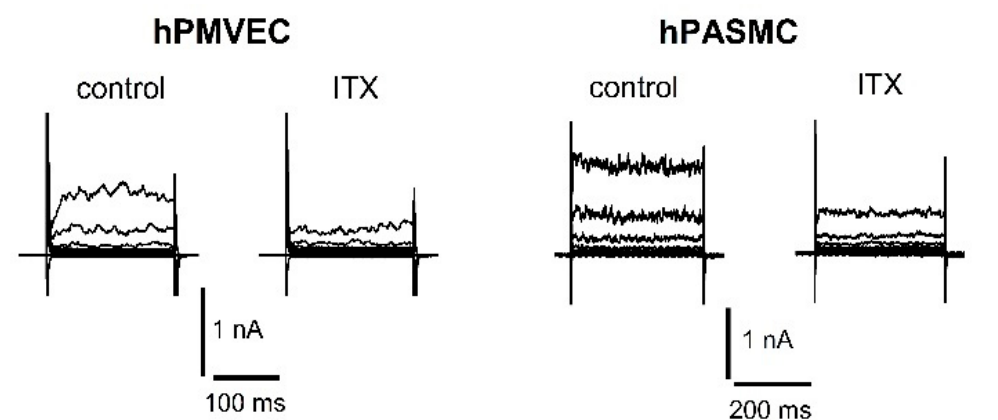
Figure 2. Representative patch-clamp recordings of K + currents in primary human pulmonary microvascular endothelial cell (hPMVEC) and primary human pulmonary arterial smooth muscle cell (hPASMC). Recordings show control whole-cell K + current and the reduction of the current after application of 100 nM ITX. In hPMVEC, currents were evoked from a holding potential of − 50 mV using 200-ms voltage steps from − 70 up to +90 mV in +20 mV increments. In hPASMC, currents were evoked from a holding potential of − 60 mV using 400-ms voltage steps from − 80 up to +80 mV in +20 mV increments. Experimental solutions have been described previously [47] .